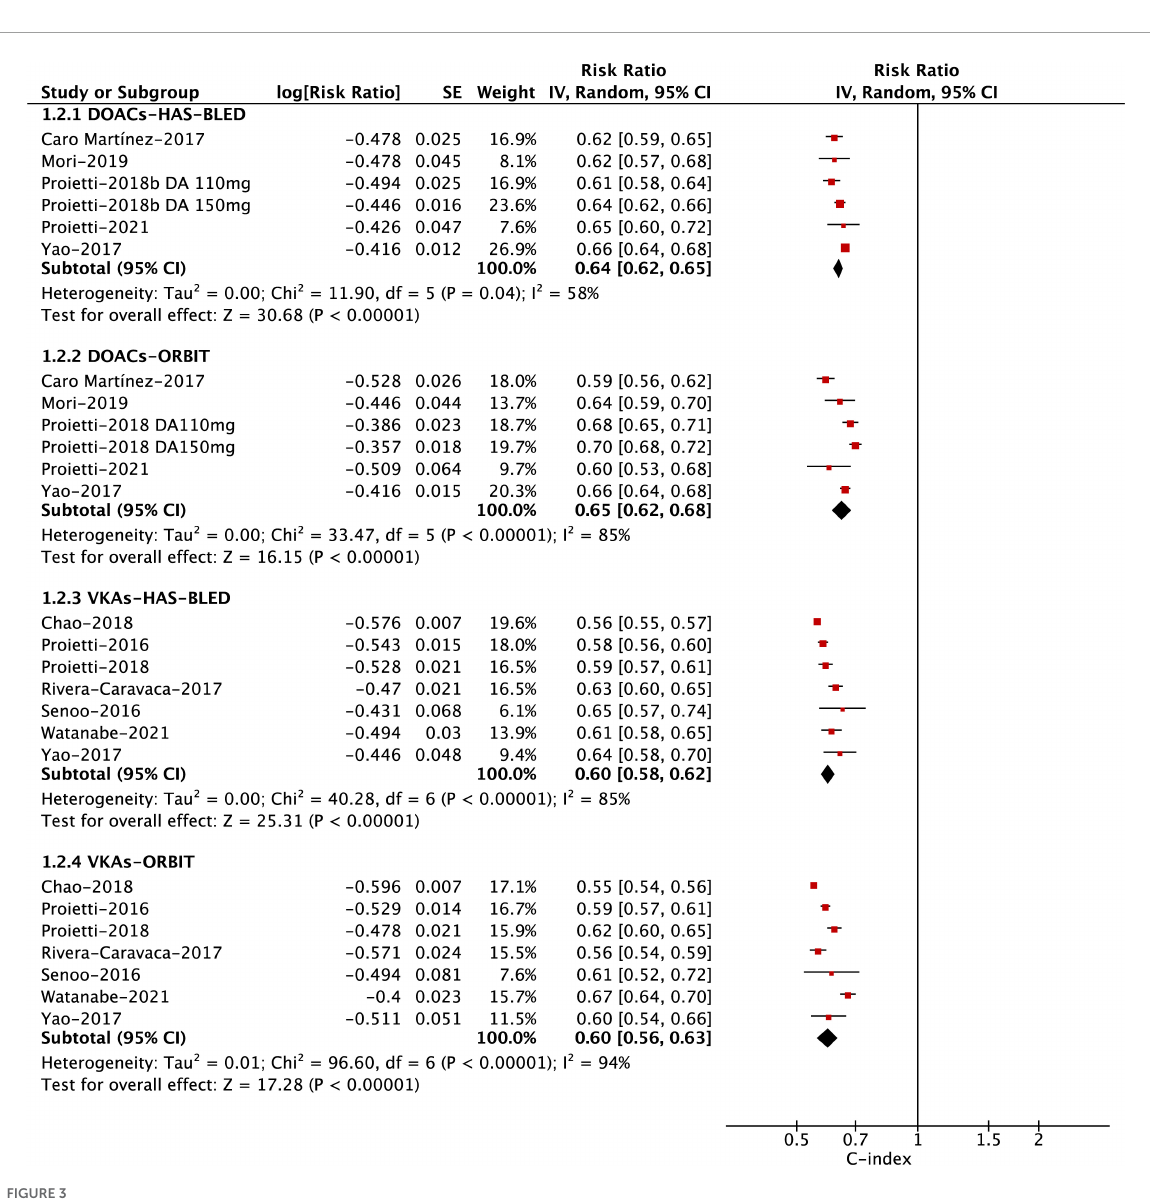
FIGURE3 Pooled analysis of the C -statistics of different subgroups by using DOAC or VKA for major